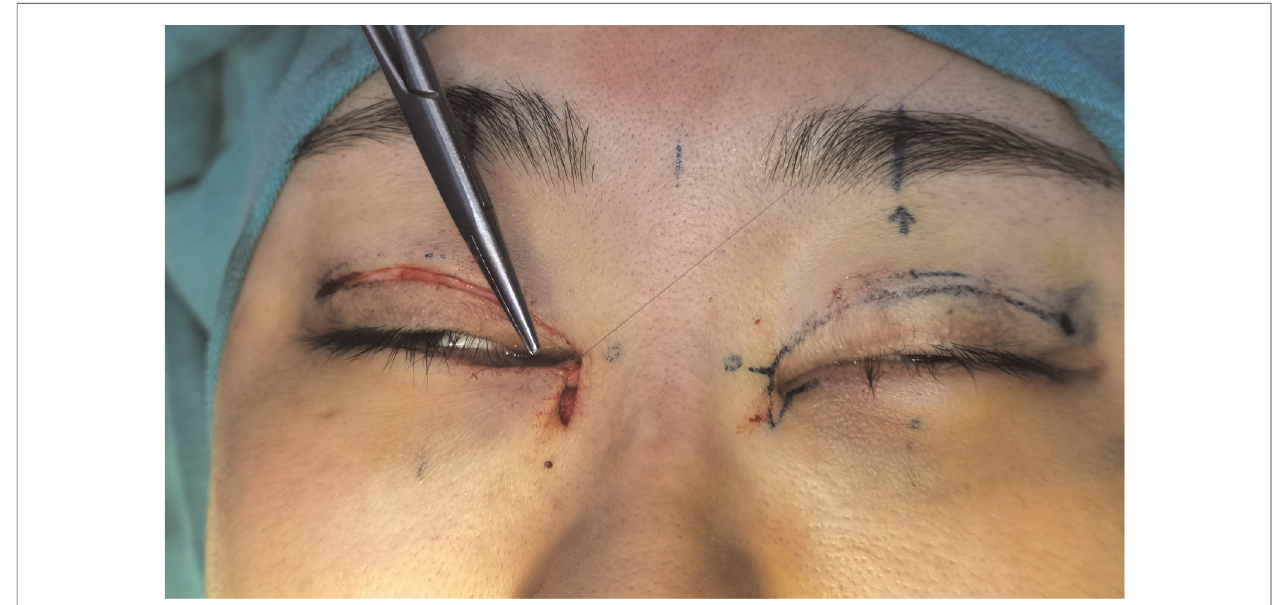
FIGURE 4 | Suture point B on the long-arm fl ap with point A on the short-arm fl ap in a suitable position.